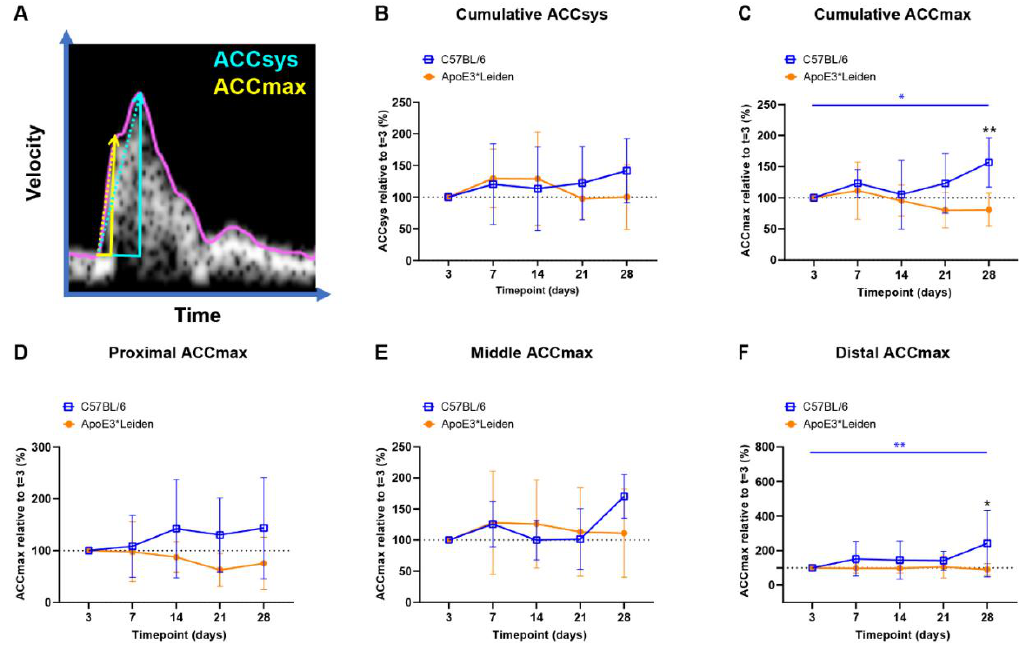
Figure 4. Blood flow acceleration in vein grafts in C57BL/6J and ApoE3*Leiden mice over time. ( A ) Example of a velocity – time curve of the blood flow in a murine vein graft during one cardiac cycle, demonstrating the difference in slope between ACCSys (blue) and ACCmax (yellow). ( B , C ) Cumula- tive relative ACCsys and ACCmax in vein grafts in C57BL/6J (n = 7) and ApoE3*Leiden mice (n = 7) for 28 days, relative to the baseline measurement at 3 days after surgery. ( D – F ) Relative ACCmax val- ues for, respectively, the proximal ( D ), middle ( E ), and distal ( F ) part of the vein grafts of C57BL/6J and ApoE3*Leiden mice. Statistics: ANOVA mixed model, corrected for multiple testing; * p < 0.05, ** p < 0.01.